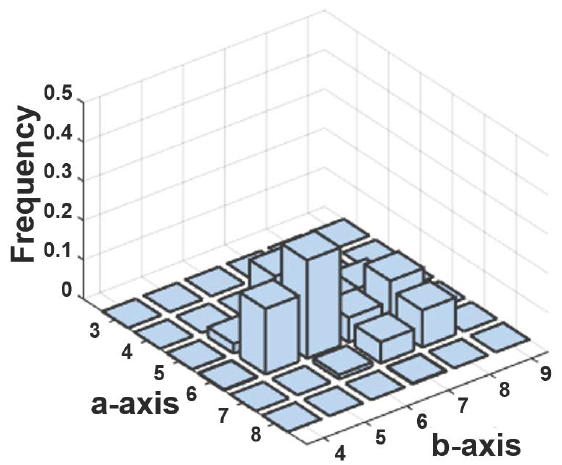
Figure 5. Mean color